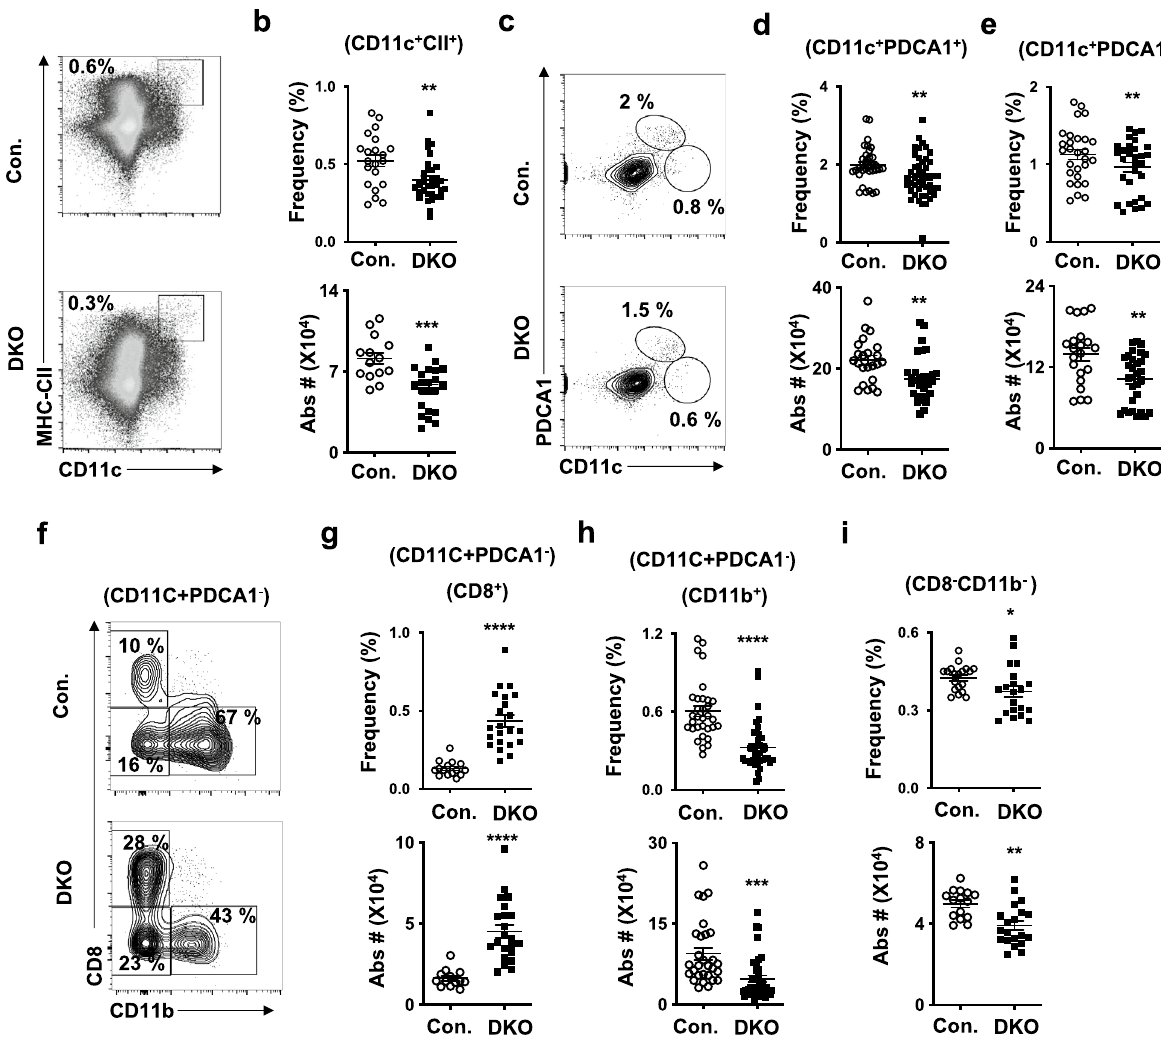
Figure 2. Loss of p85 causes reduced DC numbers in the BM. ( a ) FACS plots indicating frequencies of CD11c + CII + DCs in the BM of DKO and control mice. Shown are the frequencies within the indicated gates. Data are representative of 5 independent experiments. ( b ) Frequencies (top) (n = 21–32) and absolute numbers (bottom) (n = 14–22) of CD11c + CII + DCs in the BM of DKO and control mice. Indicated are the overall frequencies within BM. ( c ) FACS plots indicating frequencies of CD11c + PDCA1 + (pDC) and CD11c + PDCA1 − fractions in the BM of DKO and control mice. Shown are the frequencies within the indicated gates. Data are representative of 5 independent experiments. ( d ) Frequencies (top) (n = 34–47) and absolute numbers (bottom) (n = 23–32) of pDCs in BM of DKO and control mice. Indicated are the overall frequencies within BM. ( e ) Frequencies (top) (n = 25–30) and absolute numbers (bottom) (n = 21–30) of CD11c + PDCA1 − cells in the BM of DKO and control mice. Indicated are the overall frequencies within BM. ( f ) FACS plots indicating frequencies of CD8 + , CD11b + and CD8 − CD11b − subsets within CD11c + PDCA1 − fraction of BM of DKO and control mice. Shown are the frequencies within the indicated gates. Data are representative of 5 independent experiments. ( g ) Frequencies (top) (n = 15–22) and absolute numbers (bottom) (n = 13–22) of CD8 + cells within CD11c + PDCA1 − cells in the BM of DKO and control mice. Indicated are the overall frequencies within BM. ( h ) Frequencies (top) (n = 32–40) and absolute numbers (bottom) (n = 24–32) of CD11b + cells within CD11c + PDCA1 − cells in the BM of DKO and control mice. Indicated are the overall frequencies within BM. ( i ) Frequencies (top) (n = 19–20) and absolute numbers (bottom) of CD8 − CD11b − (n = 15–20)cells within CD11c + PDCA1 − cells in BM of DKO and control mice. Indicated are the overall frequencies within BM. Data represent mean and s.e.m. Two-tailed student’s t tests were used to assess statistical significance (* P < 0.05, ** P < 0.01, *** < 0.001, **** <